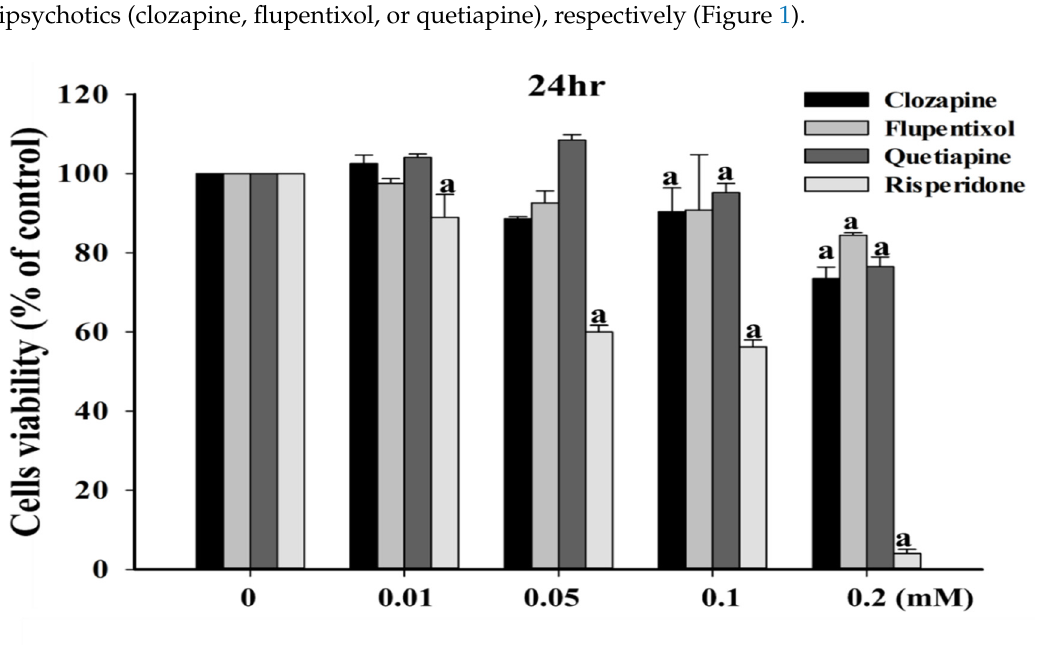
Figure 1. Effects of different antipsychotics on the survival of SW480 cells. “a” indicates a significant difference ( p < 0.05) compared with clozapine, flupentixol, quetiapine, or the risperidone control (0 mM), respectively. Similar results were obtained in three to six repeated experiments. We conducted further cell and animal studies only for risperidone because risperidone exhibited the strongest toxic effect on the survival of SW480 cells. A normal colorectal epithelial cell line, CCD 841 CoN, was adopted as normal control. The results indicated that SW480 cells are more susceptible than CCD 841 CoN cells to the effects of risperidone after 48 h of treatment with risperidone than after treatment with other antipsychotics. Remarkable and dose-dependent cell viability was observed in SW480 cells that were treated with different concentrations of risperidone (Figure 2).